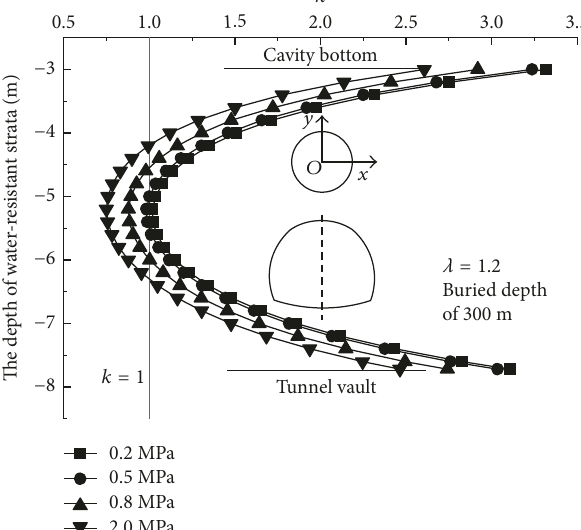
Figure 8: Influence of p on k of the water-resistant strata.